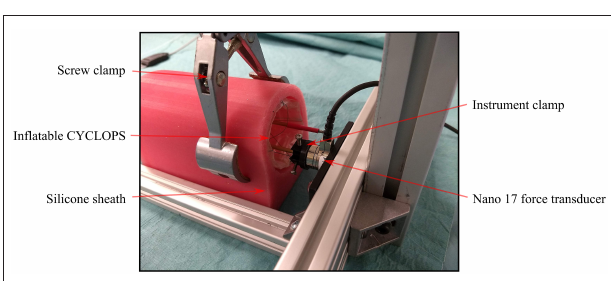
FIGURE 7 | Force exertion test setup showing the right overtube rigidly clamped to the force transducer and the CYCLOPS structure held by a clamp.